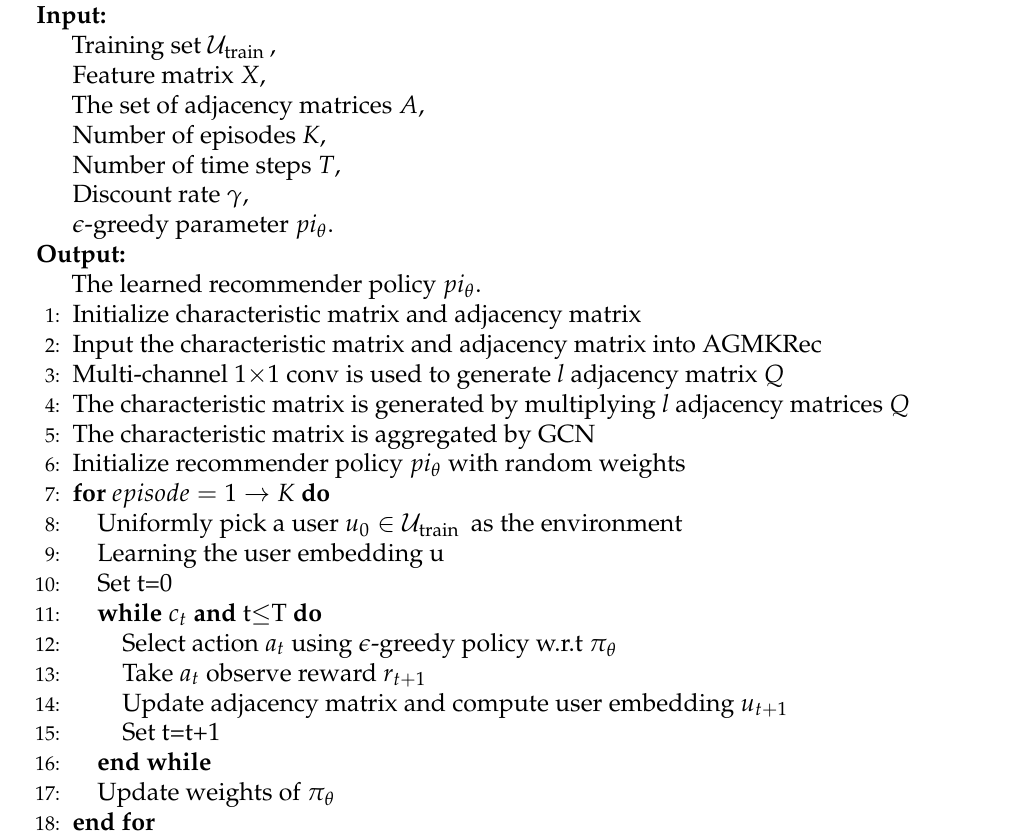
Algorithm 1 The overall learning algorithm of AGMKRec.